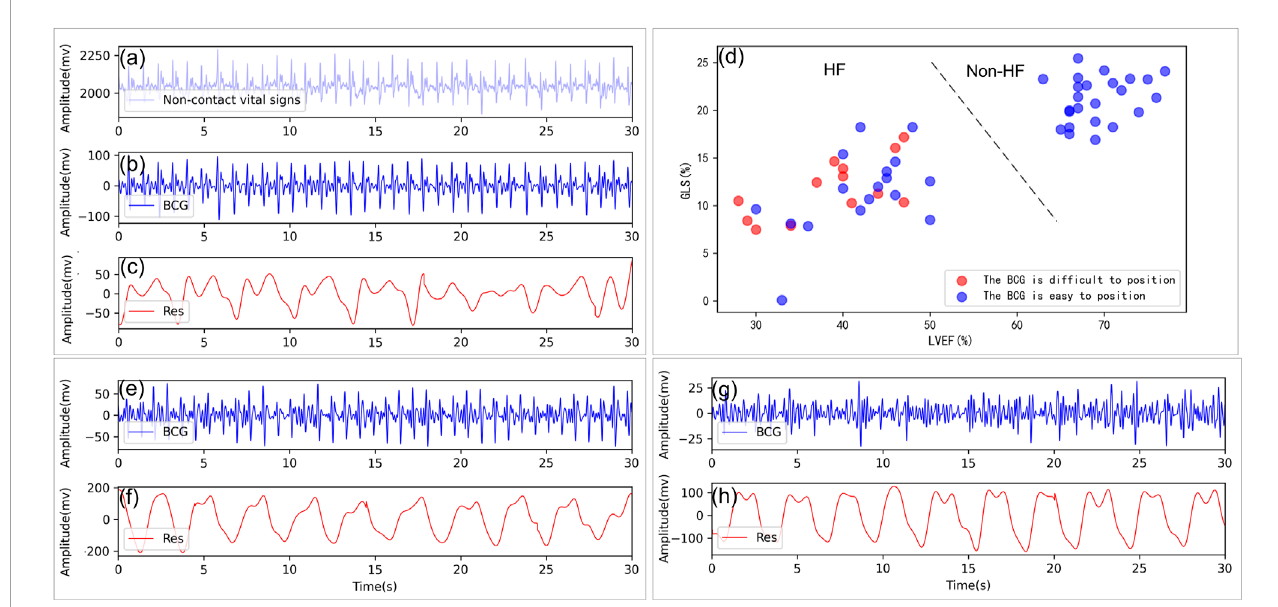
FIGURE 3 Non-contact vital sign signal processing and analysis. (A) Example of a non-contact vital sign signal collected. (B , C) Example of BCG and respiratory signals isolated from a healthy subject, GLS = 21.30%, LVEF = 76%. (D) Distribution of the J-peaks of the BCG for those who are difficult located (red circles) and those who are easier located (blue circles) in terms of LVEF, GLS. (E , F) Example of BCG and respiratory signals from a patient with HF with BCG can be located, GLS = 9.62%, LVEF = 30%. (G , H) Example of BCG and respiratory signals from a patient with HF with heartbeat are very difficult to locate, GLS = 16.07%, LVEF = 46%. Res: respiratory